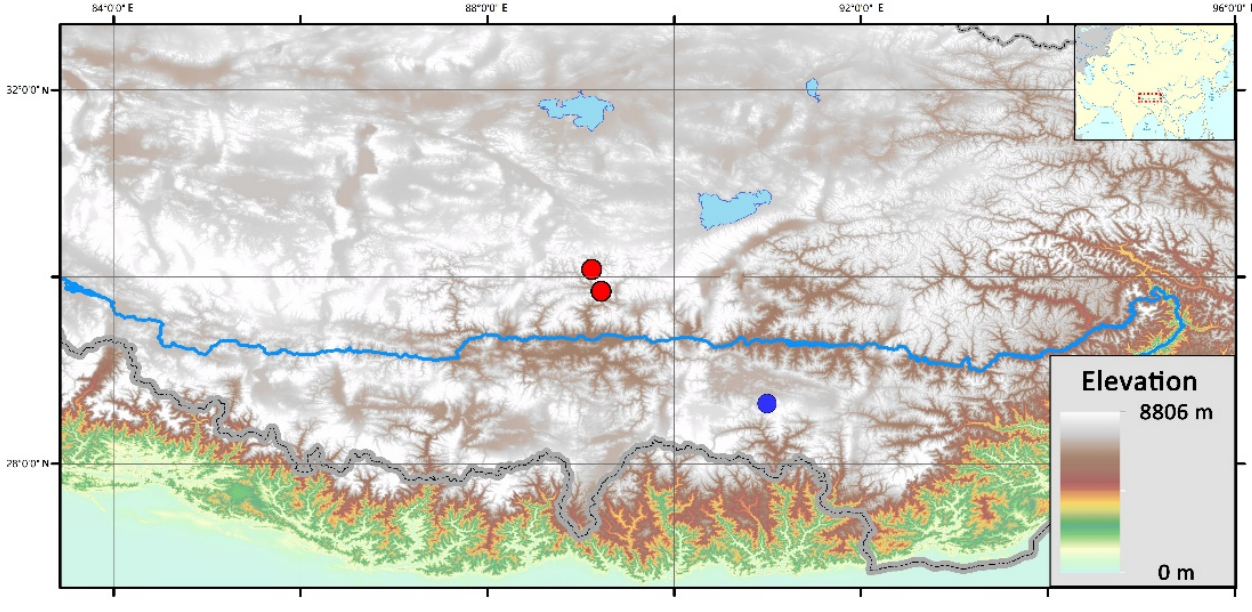
Figure 6. Geographic distribution. Blue dot shows Rhodiola wangii S.Y. Meng. Red dots show R. namlingensis S.Y. Meng.